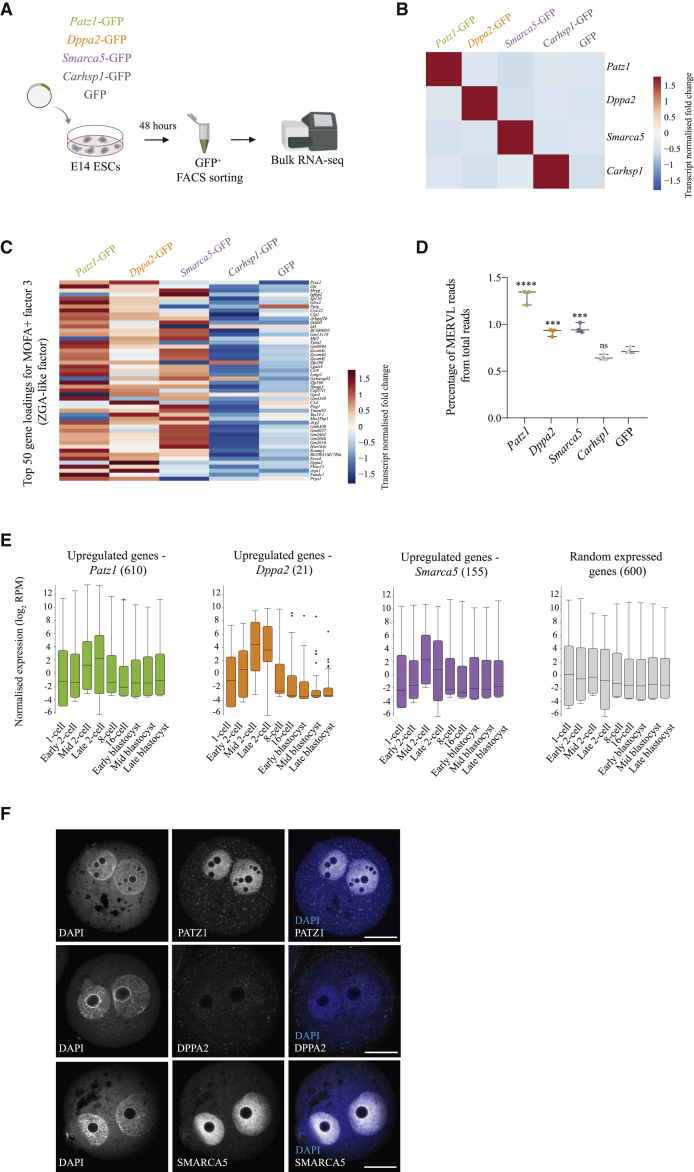
Patz1, Dppa2, and Smarca5 Are Potent Inducers of ZGA-like Transcription(A) Schematic representation of a complementary validation approach for Patz1, Dppa2, and Smarca5, using Carhsp1 as a negative control, consisting of cDNA-eGFP transient transfections into mouse ESCs followed by eGFP+ fluorescence-activated cell sorting (FACS) and bulk polyA-capture RNA-seq.(B) Heatmap showing normalized gene expression, scaled per gene, of Patz1, Dppa2, Smarca5, and Carhsp1 in bulk RNA-seq libraries after cDNA overexpression of these genes, compared with an eGFP-only transfection.(C) Heatmap showing normalized gene expression, scaled per gene, of the top 50 gene loadings for MOFA+ factor 3 (ZGA-like factor) in bulk RNA-seq libraries for Patz1, Dppa2, Smarca5, and Carhsp1 cDNA overexpression. The control is a eGFP-only transfection.(D) Box-whisker plots showing expression of the MERVL repeat family in percentage of total reads measured by bulk RNA-seq after cDNA overexpression of Patz1 (green), Dppa2 (orange), Smarca5 (purple), and Carhsp1 (gray). The control is an eGFP-only transfection (gray). Each dot represents a biological replicate. Statistically significant differences to eGFP-only control are reported as ∗∗∗∗p value < 0.0001, ∗∗∗p value < 0.001, ns (non-significant): p value > 0.05; Mann-Whitney two-tailed test.(E) Box-whisker plots showing normalized expression levels (log2 reads per million; RPM) of differentially upregulated genes by both arrayed CRISPRa and cDNA overexpression of Patz1 (green), Dppa2 (orange), and Smarca5 (purple) as well as a random set of expressed genes (gray) during preimplantation development (data analyzed from Deng et al., 2014). Differential gene expression was calculated with EdgeR (FDR < 0.05). The number of analyzed genes in each case is depicted in brackets.(F) Representative single optical slices of zygotes immunostained for PATZ1, DPPA2, and SMARCA5, showing single channels and composites with DAPI. Scale bars represent 25 μm.